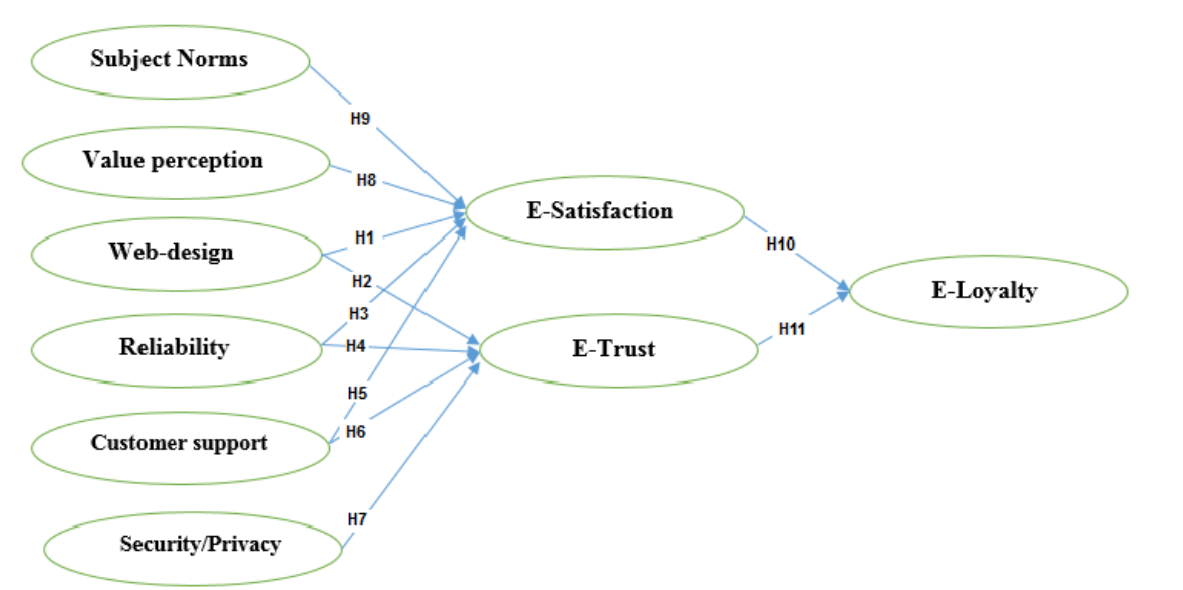
Fig. 1: The Conceptual Model of E-Banking Services